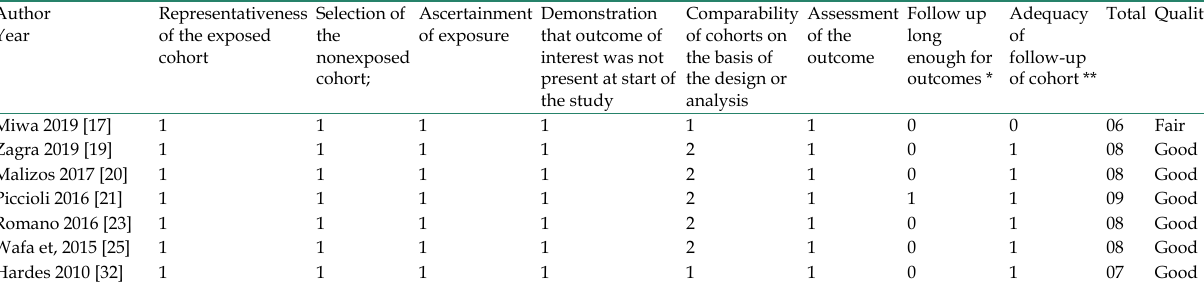
Table 2a. Study quality of the studies fulfilling the meta-analysis evaluation criteria based on the Newcastle –Ottawa